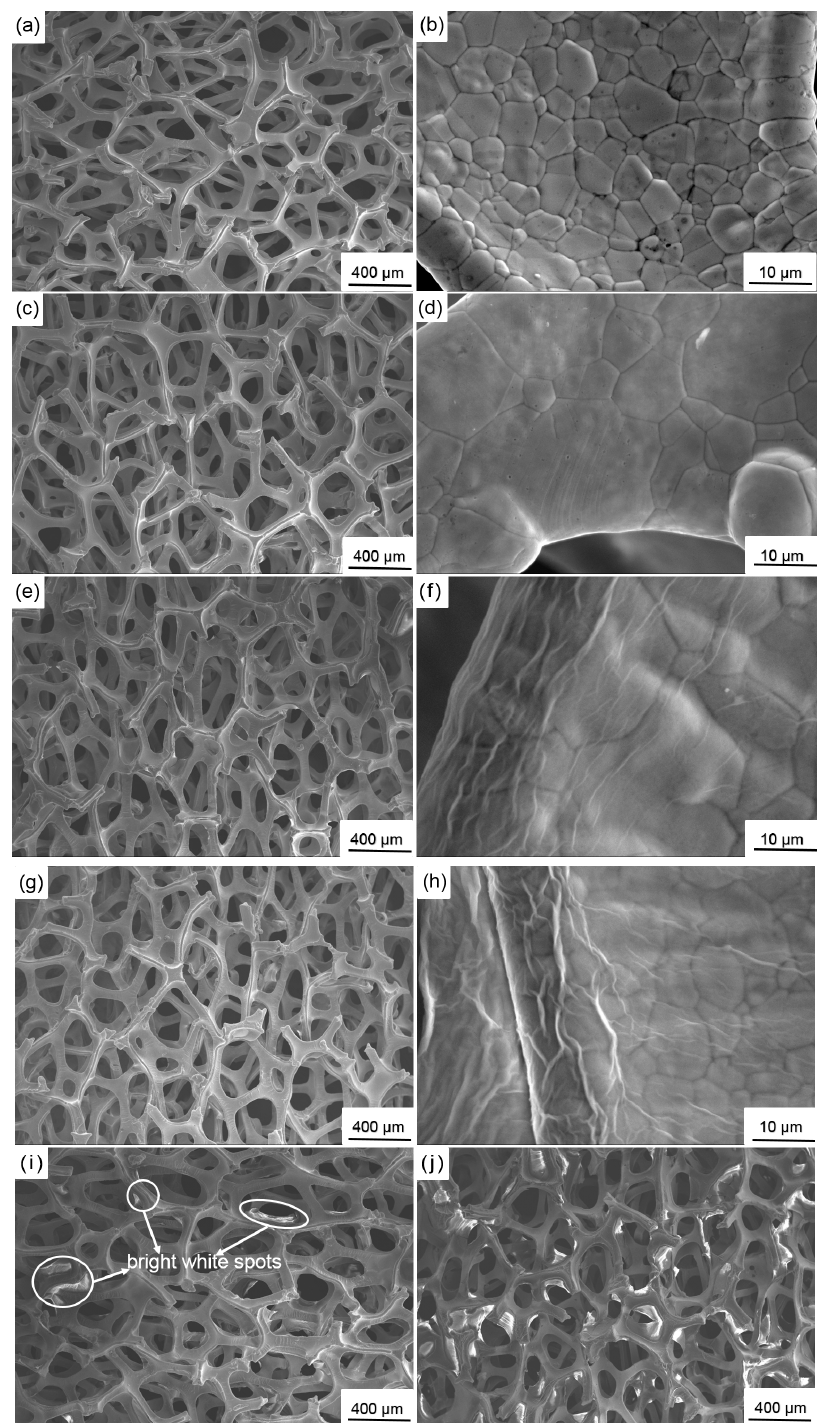
Figure 4. SEM images of ( a , b ) initial nickel foam and nickel foam covered with GO deposited at different voltages :( c , d ) 20 V; ( e , f ) 40 V; ( g , h ) 60 V; ( i ) 80 V; and ( j ) 100 V.